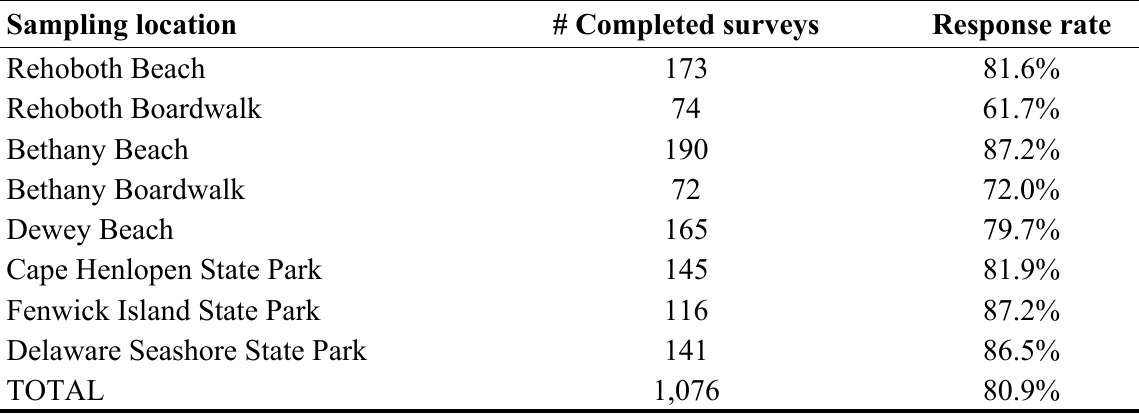
Table 1. Surveys completed and response rates by sampling